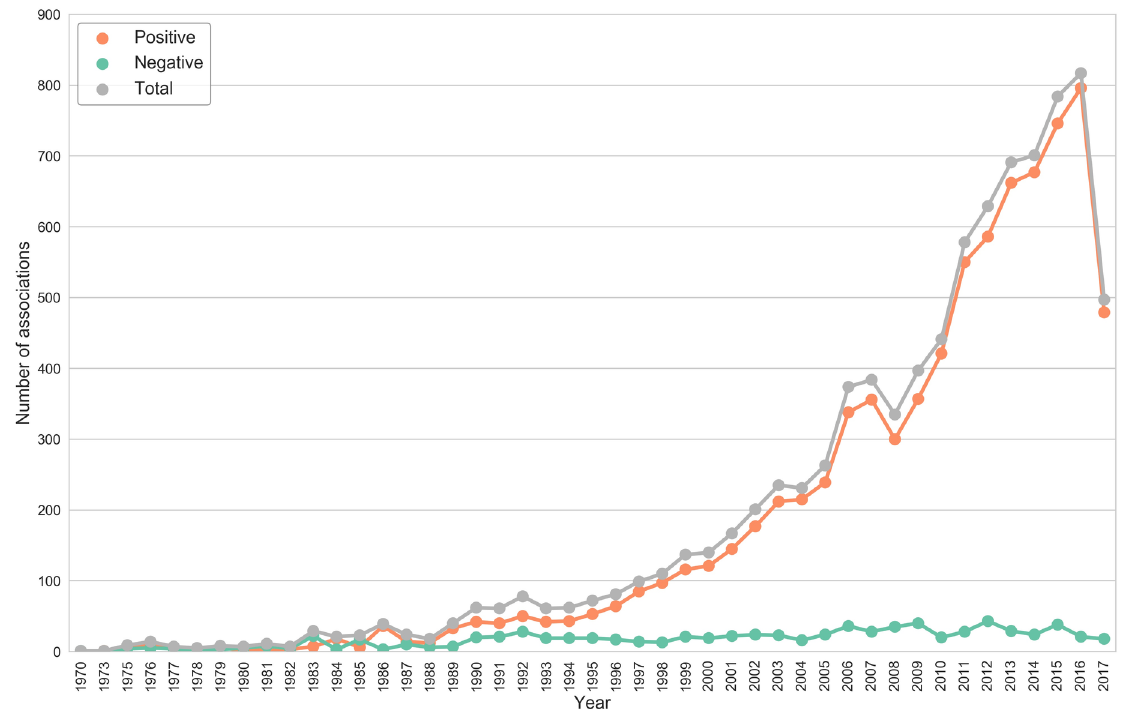
Fig 2. Statistics of spice-disease associations. Historical trend in biomedical literature reporting spice-disease associations. There is an exponential increase in articles reporting the therapeutic effects of spices in last few decades. Data of research articles archived in MEDLINE till July 2017 is represented in the